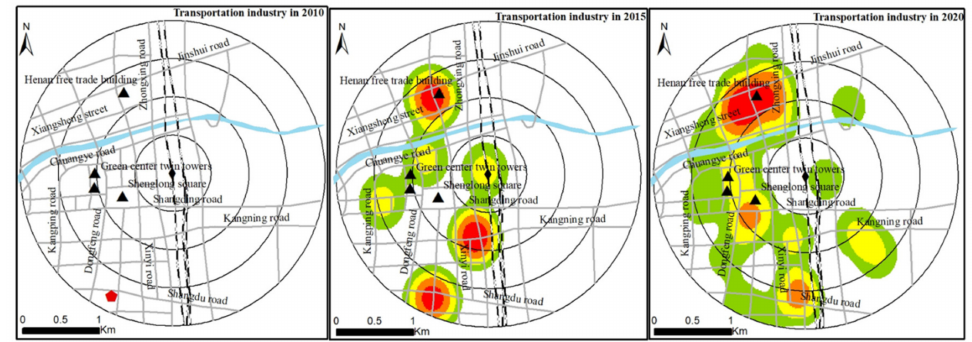
Figure 3. Kernel density analysis of the transportation industry.